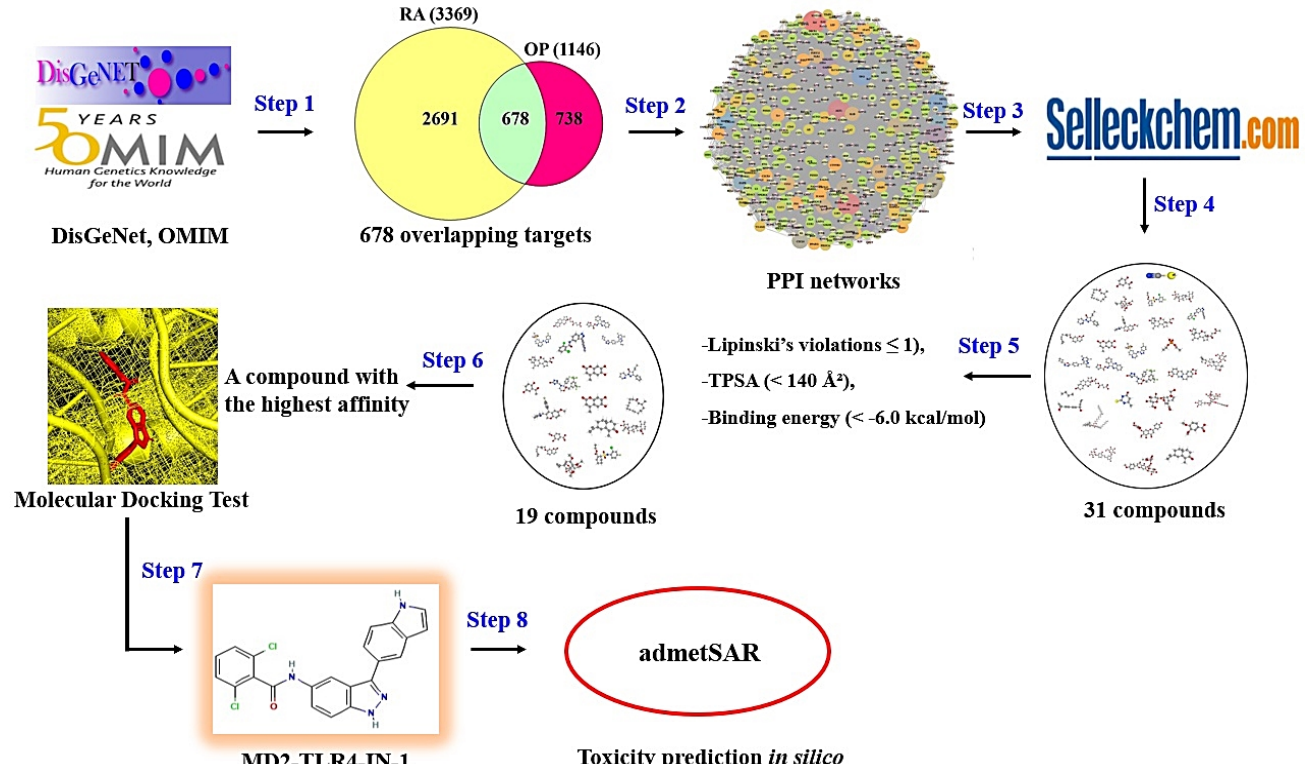
Figure 1. The workflow of this study.